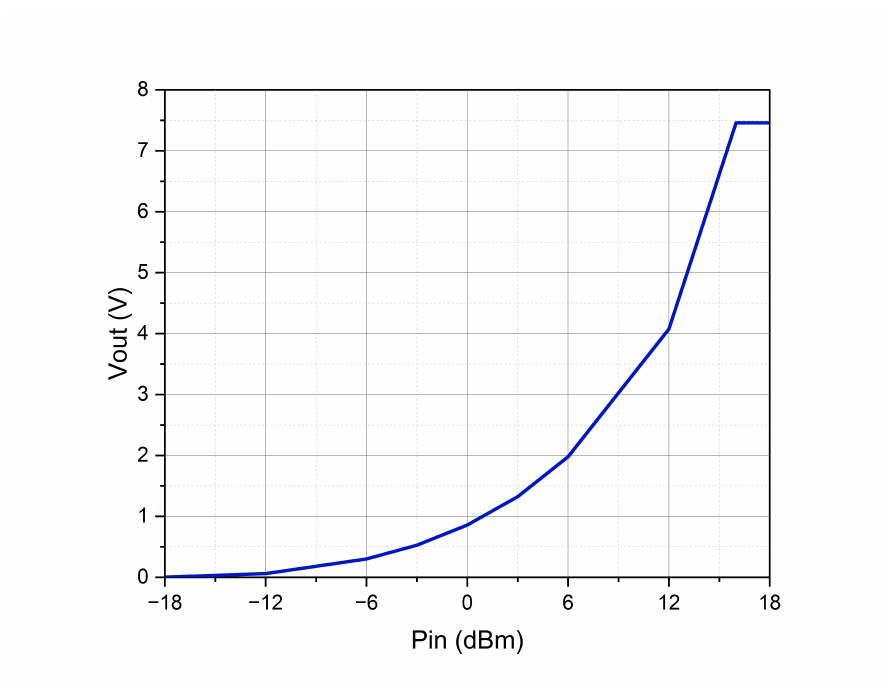
Figure 9. Output voltage versus input power.